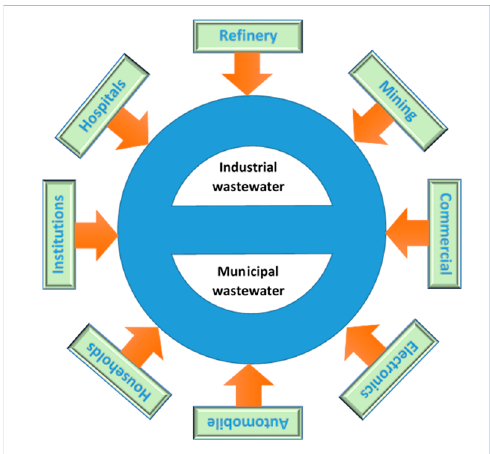
Figure 1. Depicts a schematic representation of industrial and municipal wastewater sources